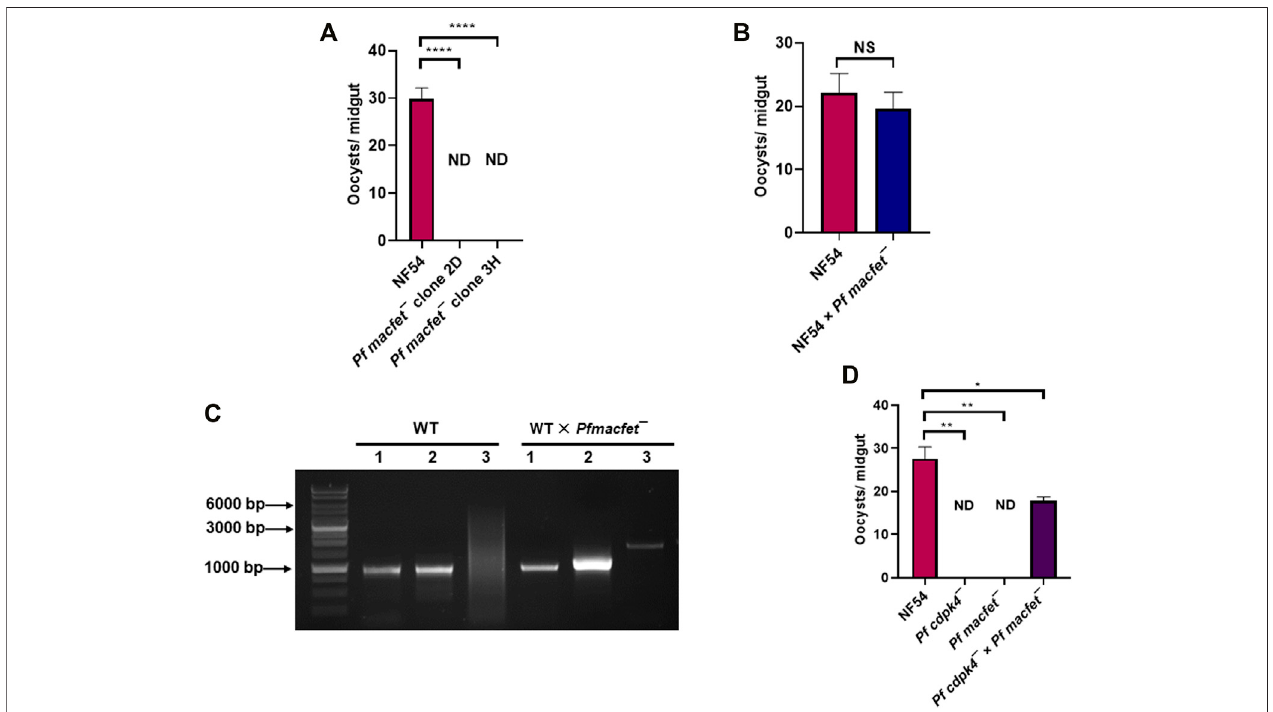
FIGURE 6 | Pf MaCFET regulates fertility of female gametes. (A) Mosquitoes with single parasite lines or genetic crosses were dissected on day 7 post feed and number of oocysts were measured per midgut. Data were averaged from three biological replicates with a minimum of 50 mosquito guts and presented as the mean ± standard deviation (SD) n = 3. **** p -value= < 0.0001. (B) Oocyst numbers for WT Pf NF54 and the WT Pf NF54 × Pfmacfet (cid:1) cross. Error bar indicates mean ± SD; n = 2. NS-Not signi fi cant. (C) Con fi rmation of transmission of Pfmacfet (cid:1) parasites in a WT × Pfmacfet (cid:1) clone 3H genetic cross by genotyping PCR. The oligonucleotides were designed from outside the 5 ′ and 3 ′ homology regions of the PfMaCFET locus and positions as indicated by arrows in Figure 3A . (D) Oocyst formation for WT Pf NF54, Pfmacfet (cid:1) , Pfcdpk4 (cid:1) single parasite infections and the Pfmacfet (cid:1) × Pfcdpk4 (cid:1) genetic cross infection. Error bar indicates mean ± SD; n = 2. ND-Not detected, ** p -value = 0.0048, * p -value =